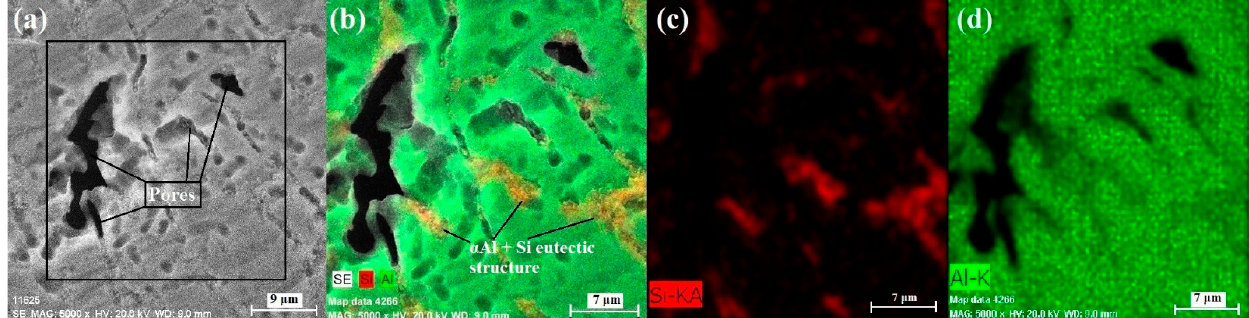
Figure 5. Cross sectional SEM micrographs of the specimen built at a welding speed of 13.3 mm/s: larger scale micrographs of samples T ( a ) and M2 ( c ) taken in the BSE mode, and closer studied areas of both samples ( b , d ) taken in the SE mode.